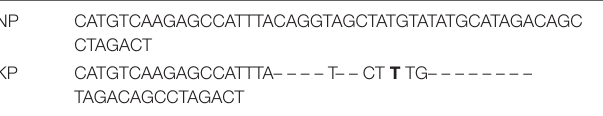
TABLE 5 | Nucleotide of the region 5,062,815–506,286 bp in chromosome 8. NP